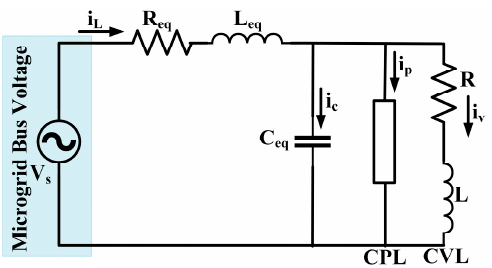
Figure 2. Equivalent circuit of an AC microgrid with CPL and CVL [26].